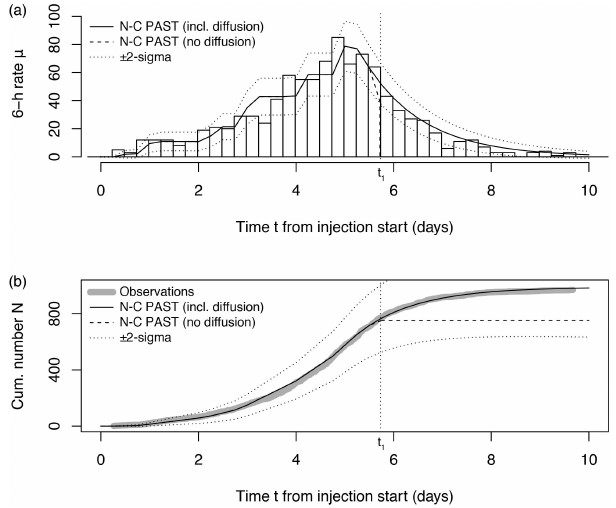
Figure 3. Induced seismicity production time series, observed and predicted: (a) histogram of the observed 6h induced seismicity rate µ(t) with fit based on Eq. (15) with MLE parameters δ bp = 4 . 68 × 10 − 7 eventm − 3 day − 1 (production parameter) and τ = 1.18 day (diffusion parameter); (b) cumulative number of induced earth- quakes N(t) with fit based on Eq. (4) with µ(t) of Eq.